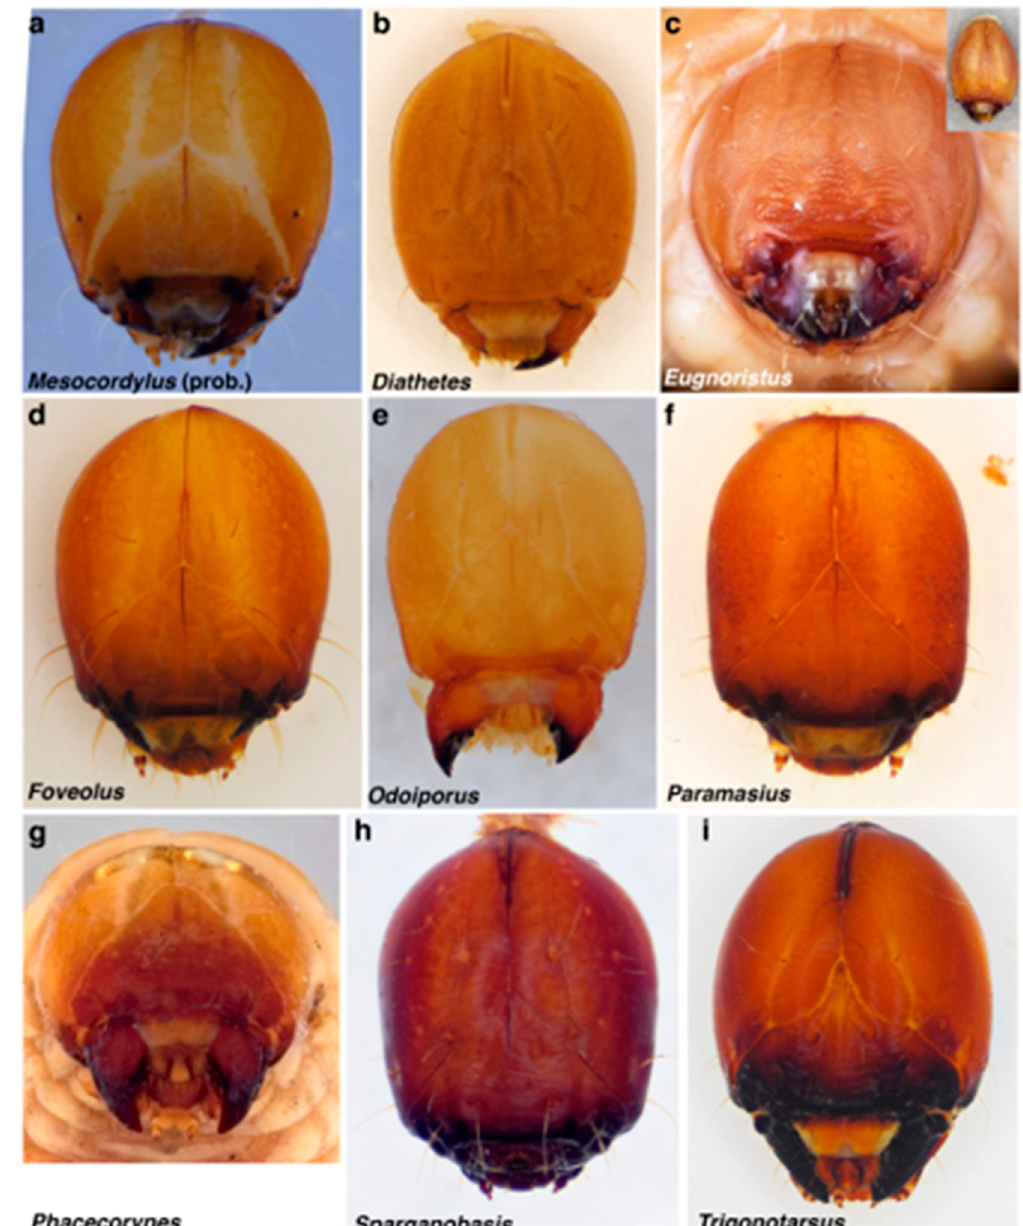
Figure 6. Head, larva, dorsal view: ( a ) Mesocordylus ; ( b ) Diathetes ; ( c ) Eugnoristus ; ( d ) Foveolus ; ( e ) Odoiporus ; ( f ) Paramasius ; ( g ) Phacecorynes ; ( h ) Sparganobasis ; and ( i ) Trigonotarsus .